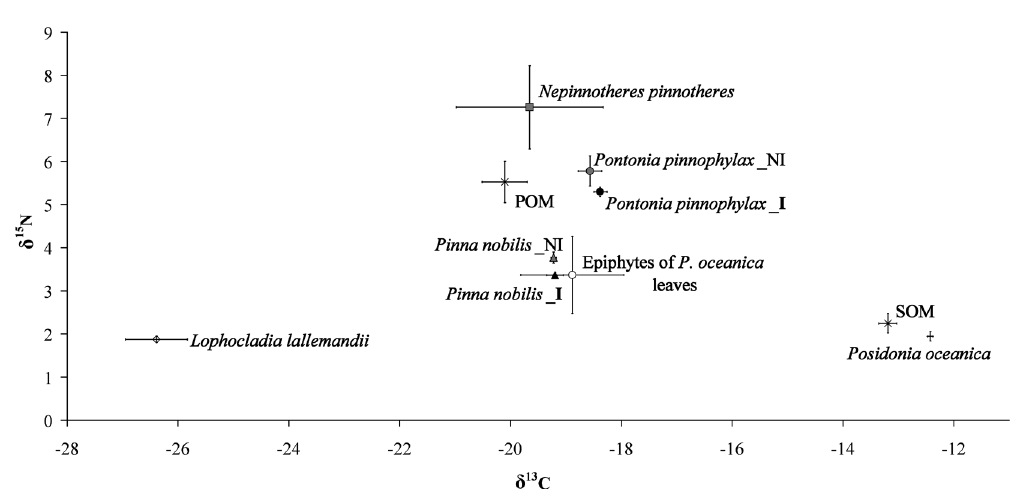
Fig . 2. – distribution of the carbon and nitrogen stable isotopes ratios (mean ± se) for the fan mussel Pinna nobilis , its decapod guests ( Pontonia pinnophylax and Nepinnotheres pinnotheres ) and the potential dietary sources. i: invaded; ni: non-invaded; PoM: particulate organic matter; soM: sediment organic matter.